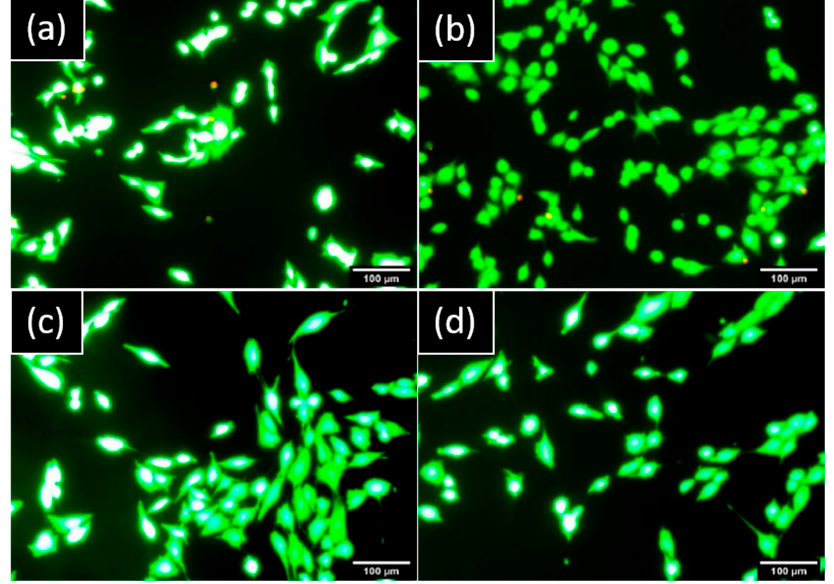
Figure 4. Representative images of cells stained by LIVE/DEAD™ observed by epifluorescence microscopy after one day: hGF in indirect contact with ( a ) NB™ and ( b ) MC ® . MG63 in indirect contact with ( c ) NB™ and ( d ) MC ® . Green areas are live cells and red areas are damaged cells. Scale bars = 100 µm.